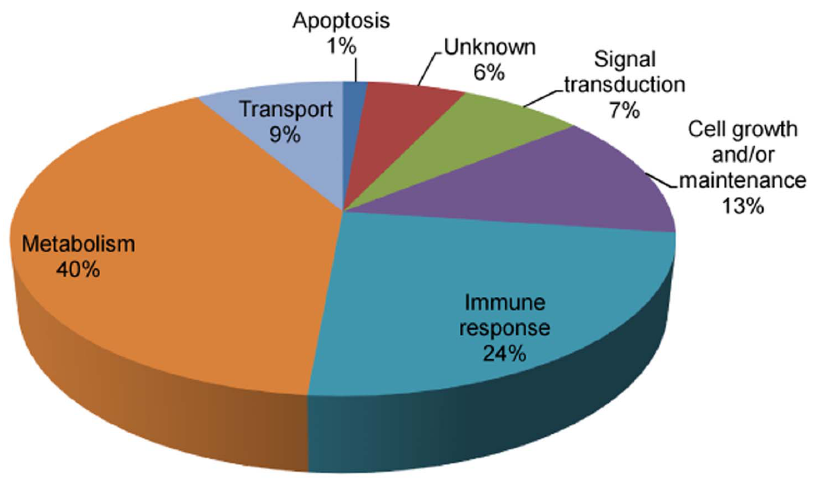
Figure 5. Pie chart showing biological processes of 70 proteins identified with high confidence in all the three workflows.